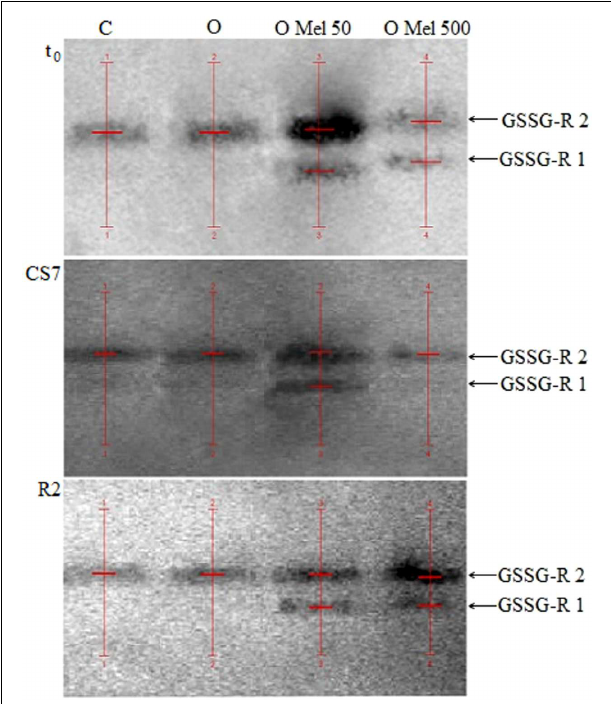
FIGURE 5 | Native gels with glutathione reductase (GSSG-R) isoenzymes extracted from embryonic axes of the cucumber seeds. The axes were isolated from control seeds (C) and those osmoprimed without (O) and with melatonin in concentration: 50 µ M (O Mel 50) and 500 µ M (O Mel 500). The seeds were germinated in water at 10 ◦ C in darkness for 7 days (CS7), and then subsequently recovered at 25 ◦ C for 2 days (R2). Enzymes were also estimated in the axes isolated from the seeds germinated 24 h in optimal conditions 25 ◦ C (t 0 ). The stripes of enzyme isoforms were detected (red lines) and estimated by densitometric analysis of gels using QuantityOne 1-D Analysis Software v. 4.6.9 (BioRad).